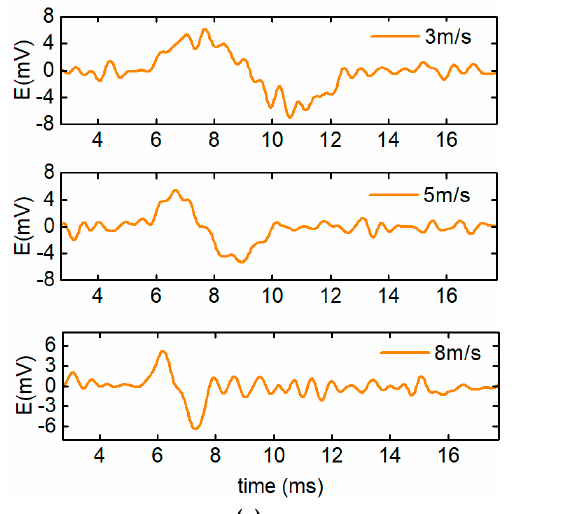
Figure 10. The raw signal of the proposed sensor.